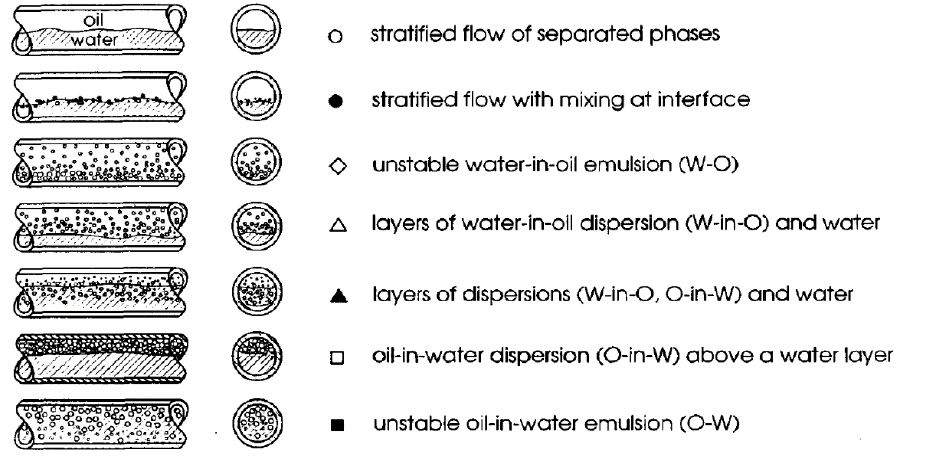
Figure 4. Schematic diagram of oil-water flow pattern in a horizontal pipeline [21].